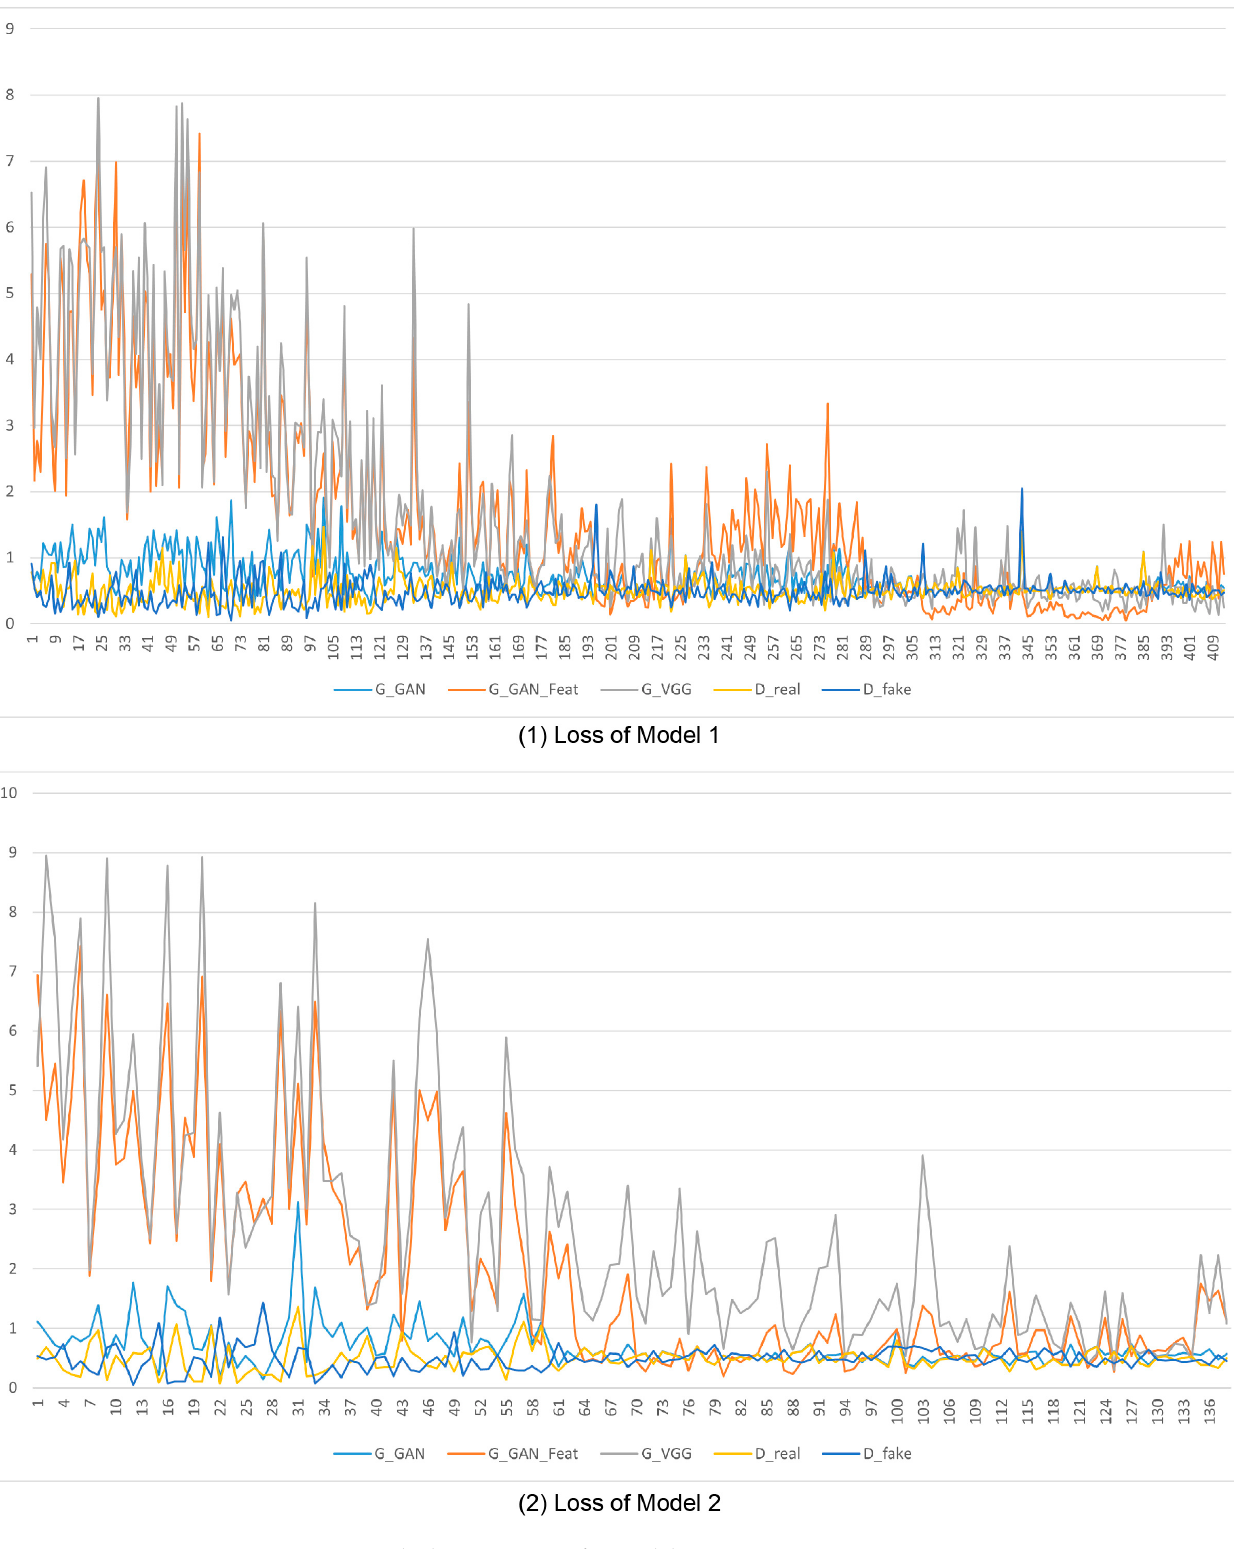
Figure 4. The learning curve for model training.